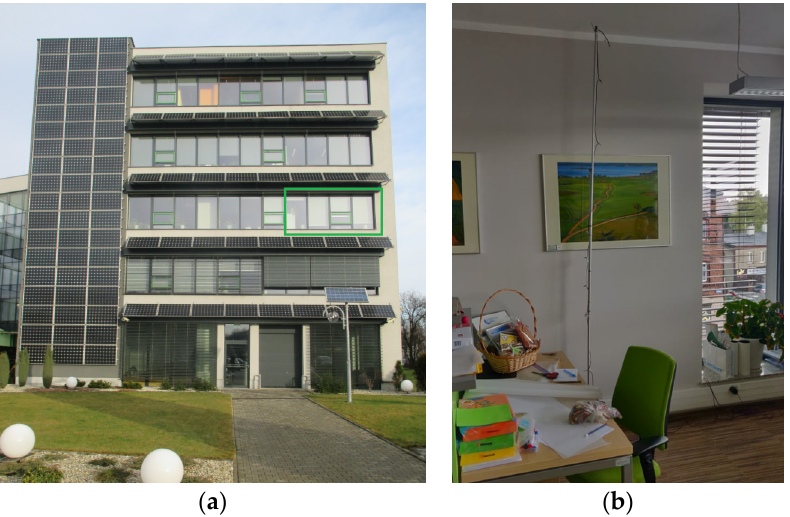
Figure 3. The test-room: ( a ) its location (green border); ( b ) internal view—sensors during assem- bling.